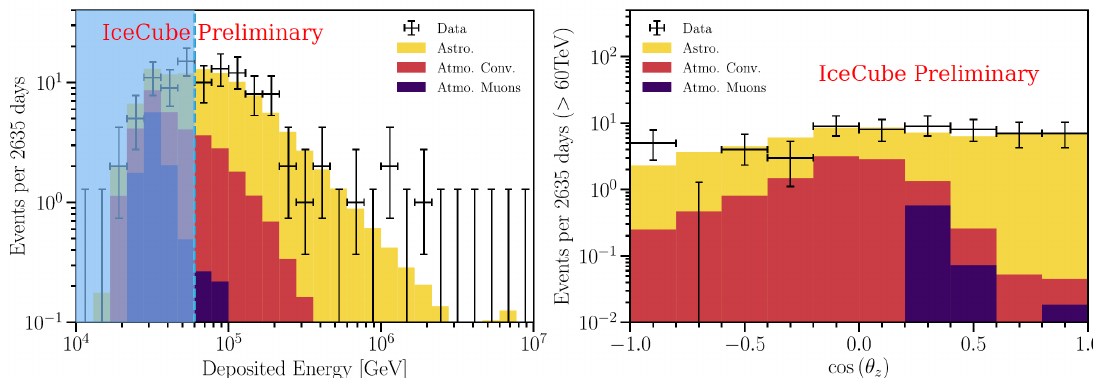
Figure 8. Deposited energies E dep (left panel) and arrival directions (right panel) of observed IceCube HESE (crosses), compared with predictions. The sample refers to 7.5 years of data. The best-fit expectation is shown as a stacked histogram with each color specifying a flux component—astrophysical (golden), conventional atmospheric (red), and penetrating muons (purple); the best fit prompt normalization is zero and is not shown. Events below 60 TeV (light blue vertical line) are not included in the fit, but one sees good data-MC agreement extending into this energy range. From the arXiv version of